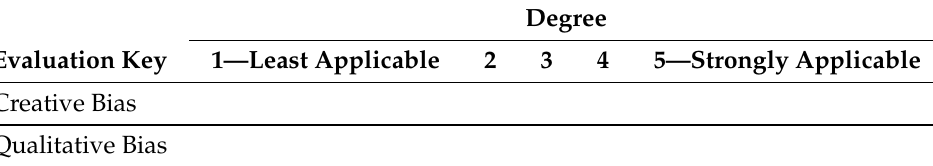
Table 3. The ‘Undesirable Measures’ of Evaluation for Degree of